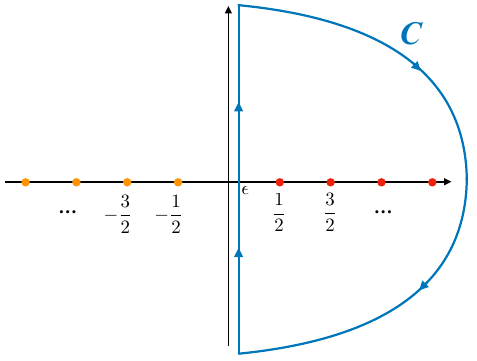
Figure 5 . C is the integration contour in the determination of the partition function as the inverse Laplace transform of